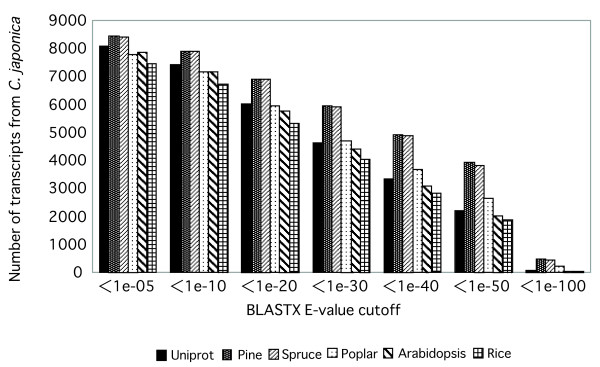
Sequence similarities. Numbers of transcript sequences of transcripts from C. japonica male strobili similar to sequences in the Uniprot, pine, spruce, poplar, Arabidopsis, and rice databases according to BLASTX E-value cutoff values.